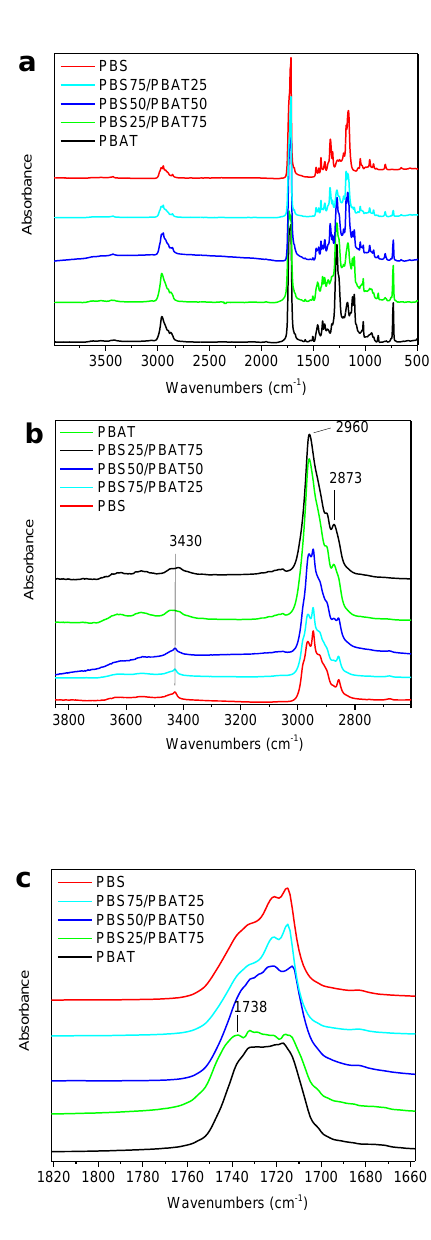
Figure 5. Infrared spectra of neat PBS, PBAT and their blends: ( a ) full spectral region, close-up view of the ( b ) C–H, and ( c ) C=O stretching regions.